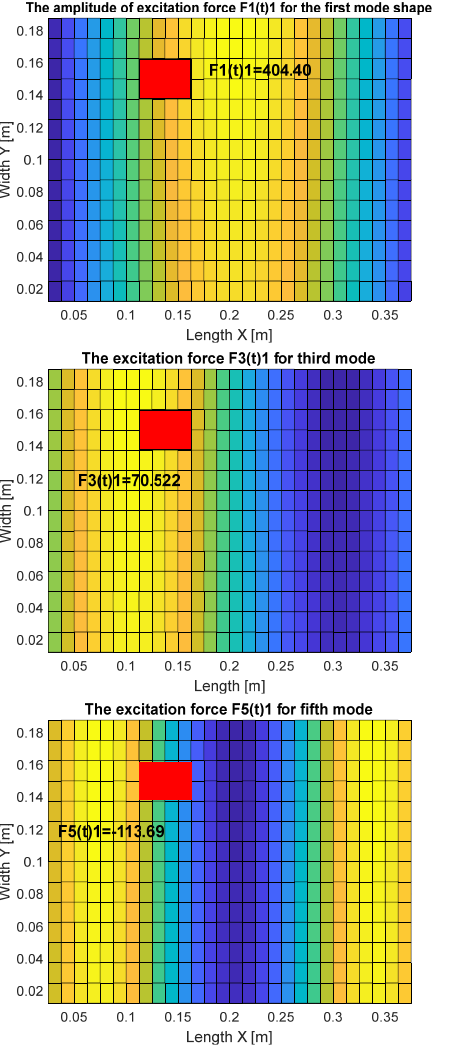
Figure 5. Maximum amplitude of the modal force calculated for piezo ‐ actuator PA_1 and piezo